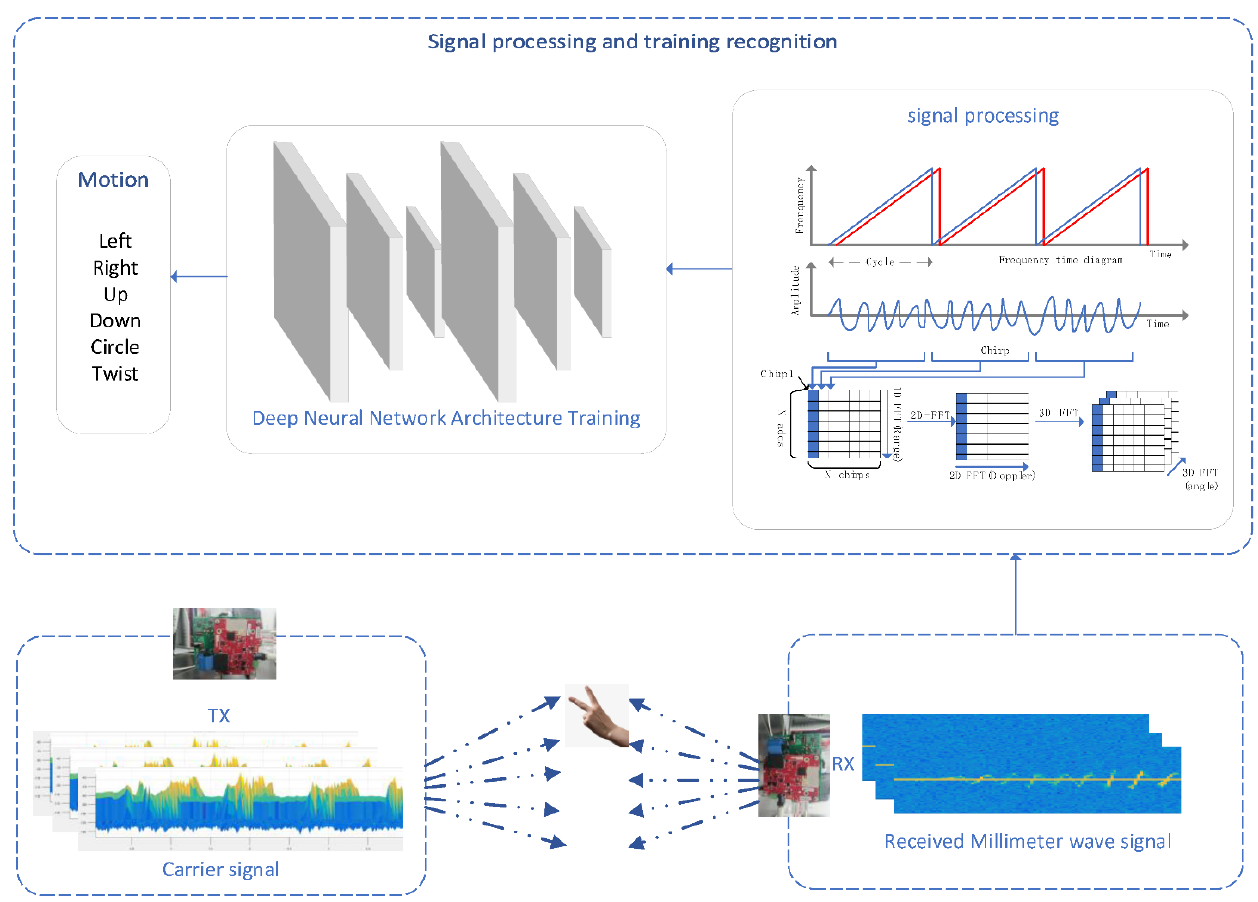
Figure 1. Millimeter-wave signal gesture recognition architecture network.